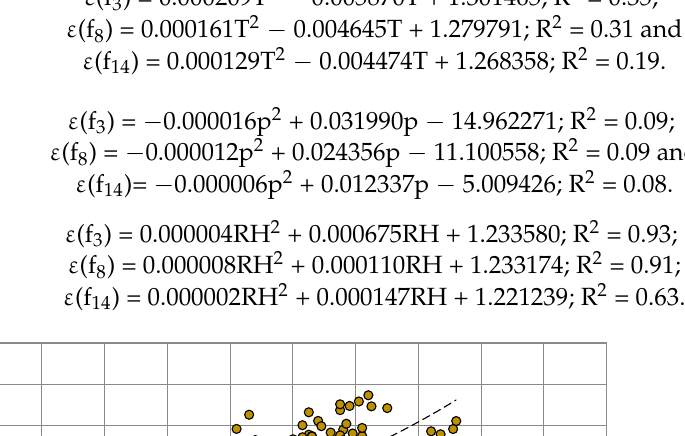
Short series number kp Stand. Cond.